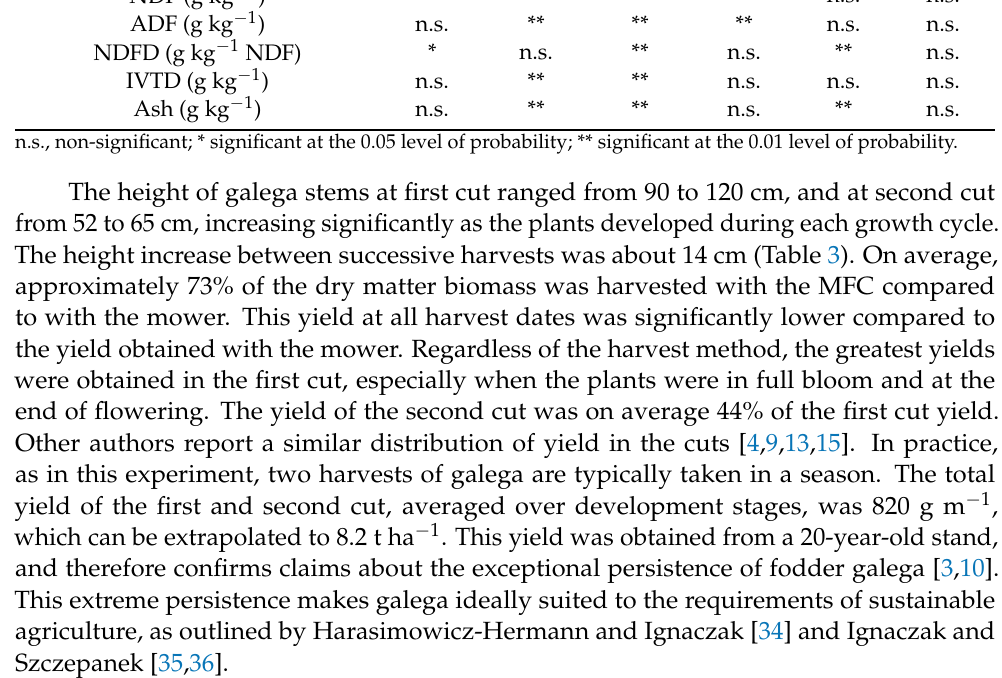
n.s., non-significant; * significant at the 0.05 level of probability; ** significant at the 0.01 level of probability.